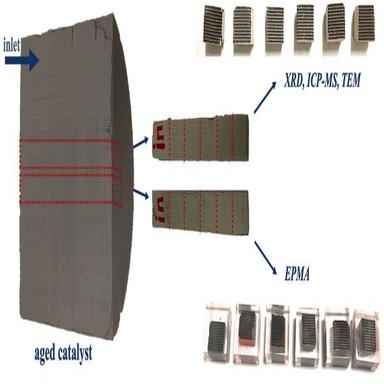
Representation of the six consecutive sections extracted from the aged automobile exhaust catalyst used for metallographic preparation and characterization.